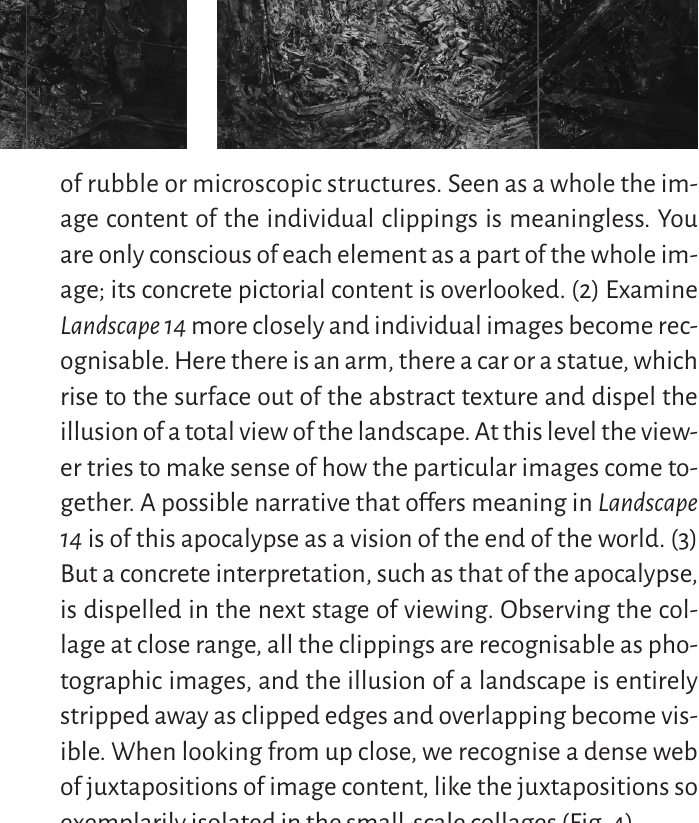
293 www.img-network.it